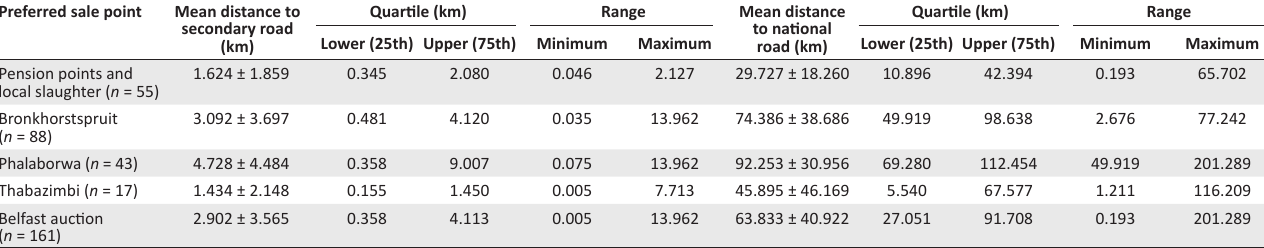
TABLE 2: Preferred point of sale for pigs and pig products and the distances to the nearest national or secondary roads. Preferred sale